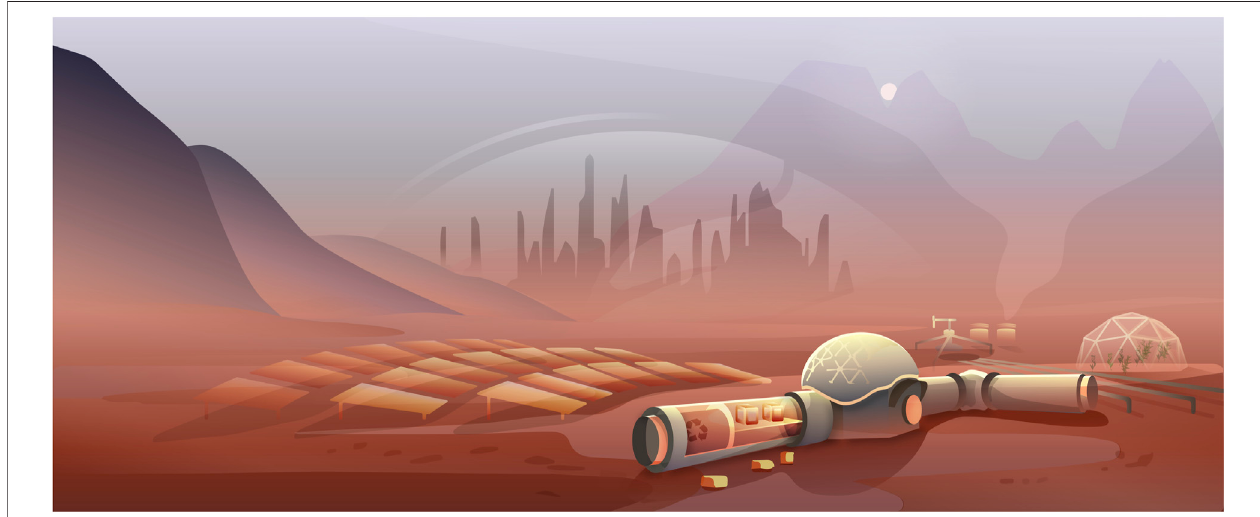
FIGURE 1 | Artist ’ s rendering of a crewed Martian biomanufactory powered by photovoltaics, fed via atmospheric ISRU, and capable of food and pharmaceutical synthesis (FPS), in situ manufacturing (ISM), and biological loop closure (LC). Artwork by Davian Ho.